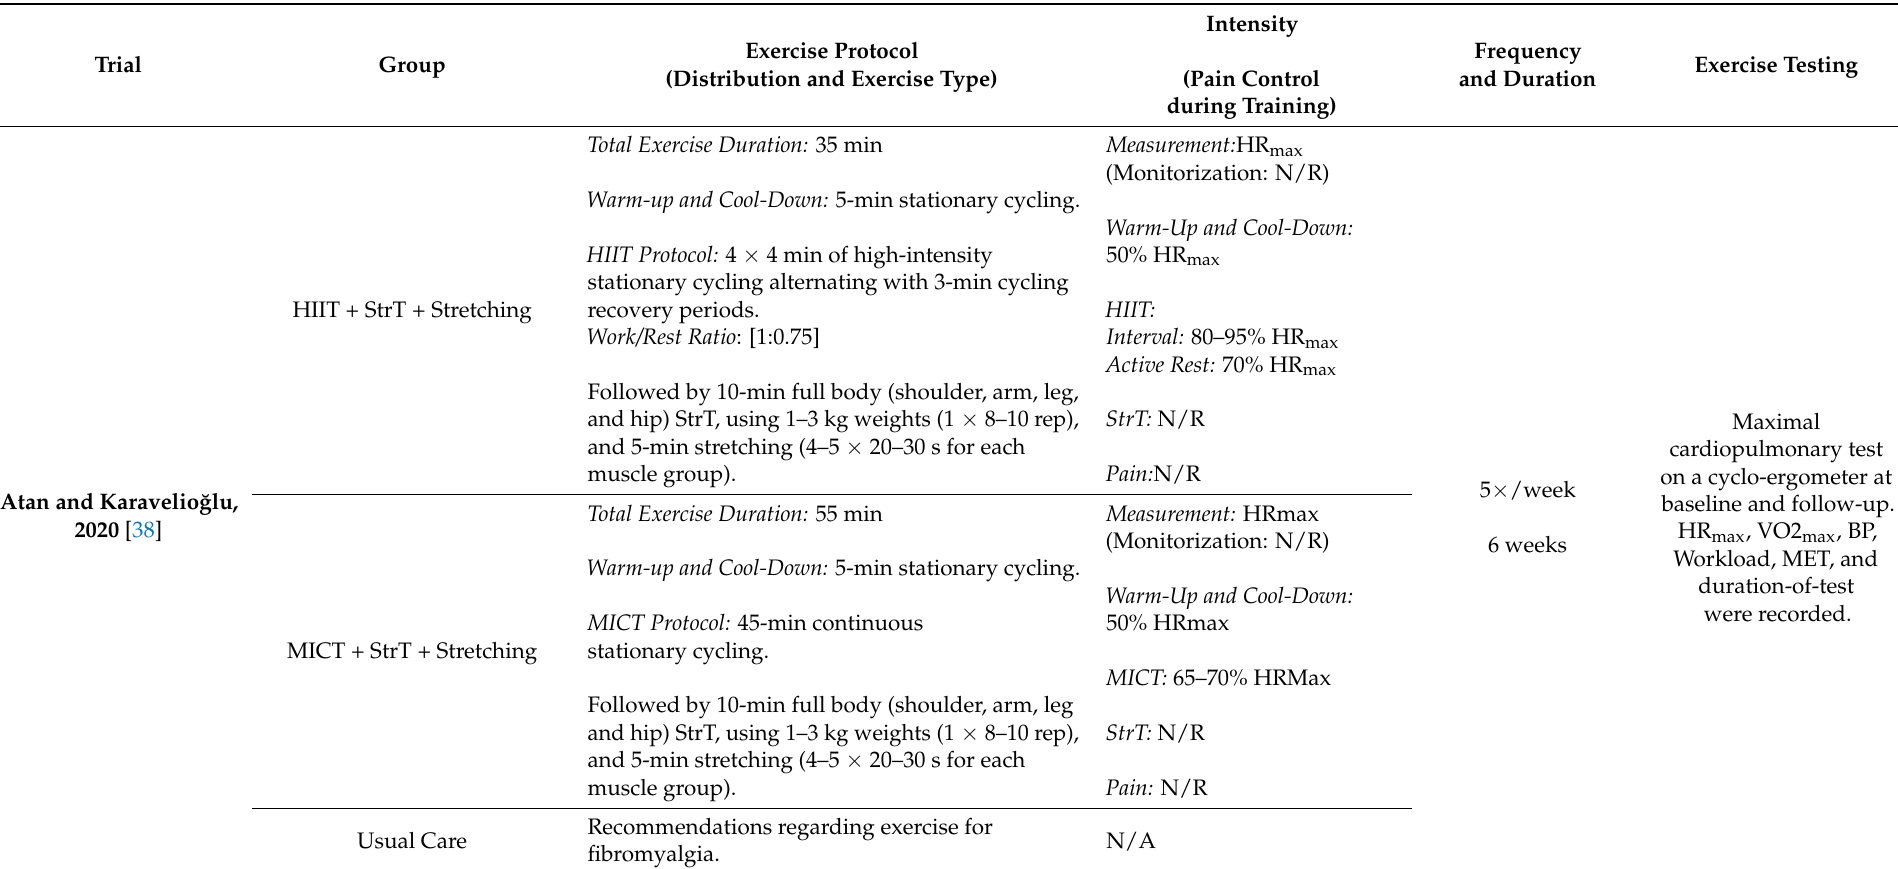
Table A2. Prescription parameters extracted from each included